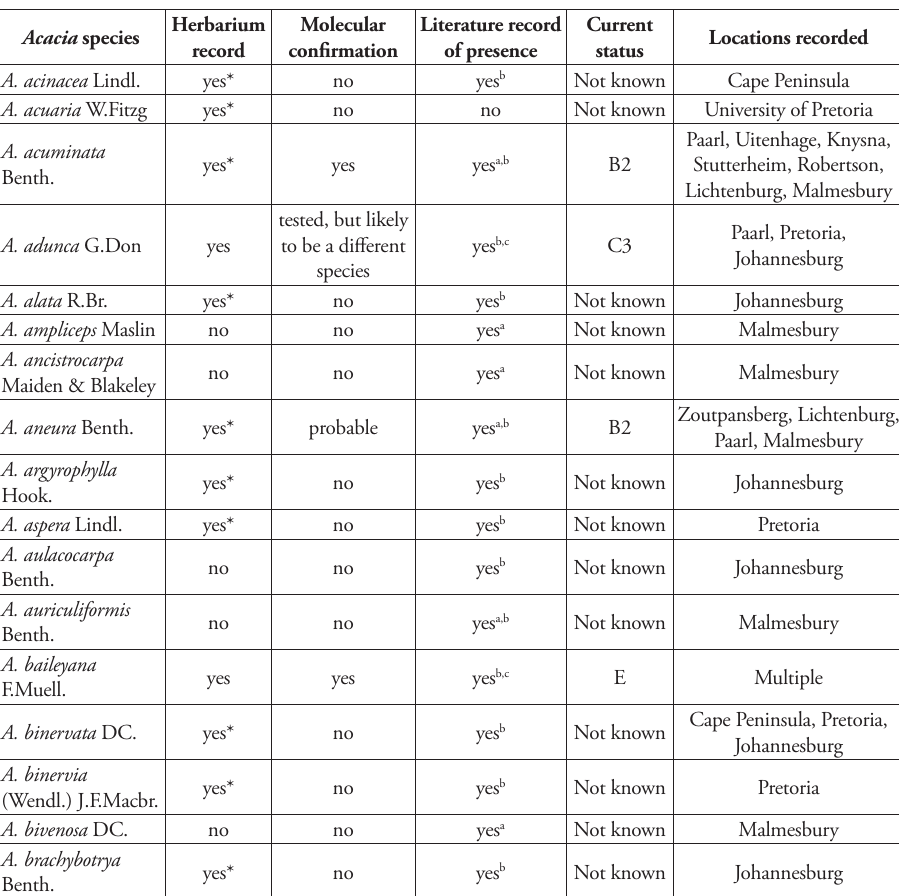
Table 1. The presence of Australian Acacia species in South Africa based on herbarium specimens, mo- lecular identification, records from historical literature sources, and the current status of populations from field sampling. Species names are as per the Plant List (The Plant List 2013, accessed 1 March 2018), with synonyms on herbarium records and literature records updated as appropriate (see notes). Herbarium re- cords in South Africa not available on-line at http://newposa.sanbi.org/ (as of 1 March 2018) are marked with asterisks *, and details provided in Suppl. material 2. Molecular confirmation of taxonomic identities of acacias in South Africa was either based on existing records in Genbank or obtained from this study (see Suppl. material 1 for details of the results from this study). If the molecular work provided some support for the identification but not unequivocal support, the confirmation is noted as “probable”. Where the putative identity did not match records of that species on Genbank (where available), then it is noted as “tested but likely to be a different species”. The literature records of presence are based on the sources listed in the notes. Current status for species found during the field surveys is as per the Unified Framework for Biological Invasions (Blackburn et al. 2011; See Appendix 1 for details, and Suppl. material 3 for the range sizes of all naturalised and invasive species). The current status of species whose presence could not be unequivocally established during field visits are indicated as “not known”. Several additional species have been recorded from neighbouring countries but not in South Africa as far as we know [ Acacia adsurgens , A. cowleana , and A. crassicarpa (Poynton 2009)]. status